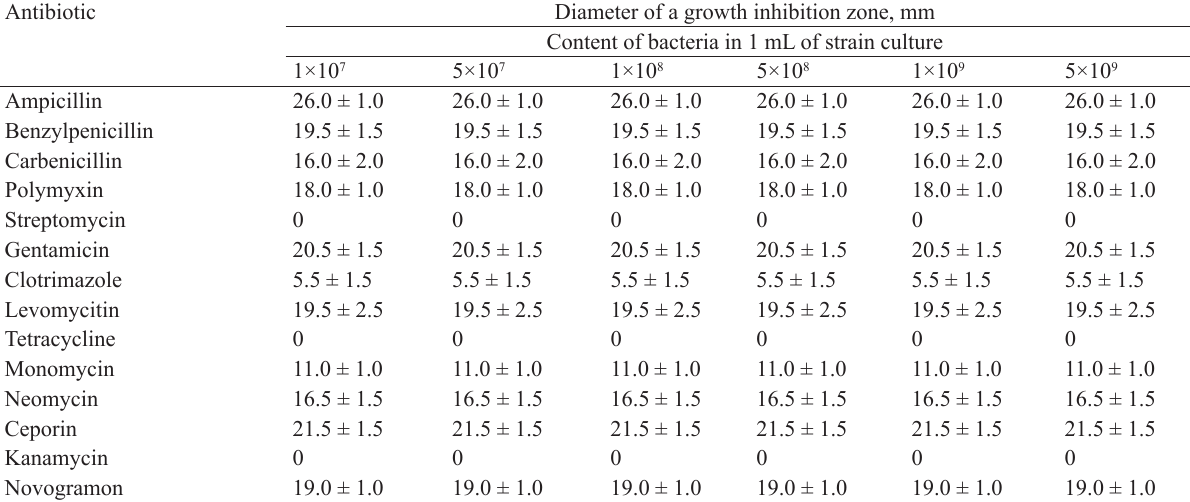
Table 5 Antibiotic resistance of Leuconostoc mesenteroides isolate Antibiotic Diameter of a growth inhibition zone, mm Content of bacteria in 1 mL of strain